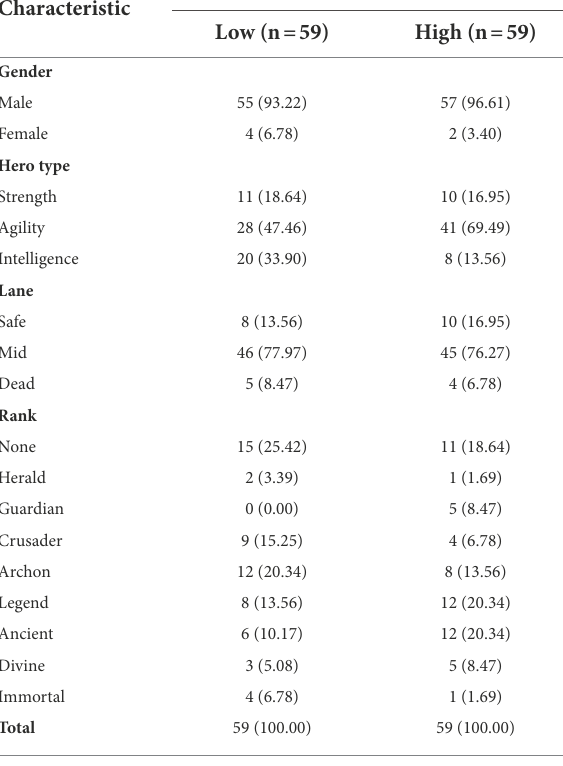
TABLE 3 Demographic characteristics of participants with high- and low-level of self-regulation, n (%).